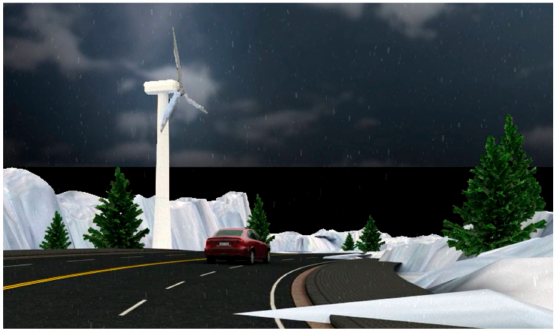
Figure 1. Icing in a wind turbine near a